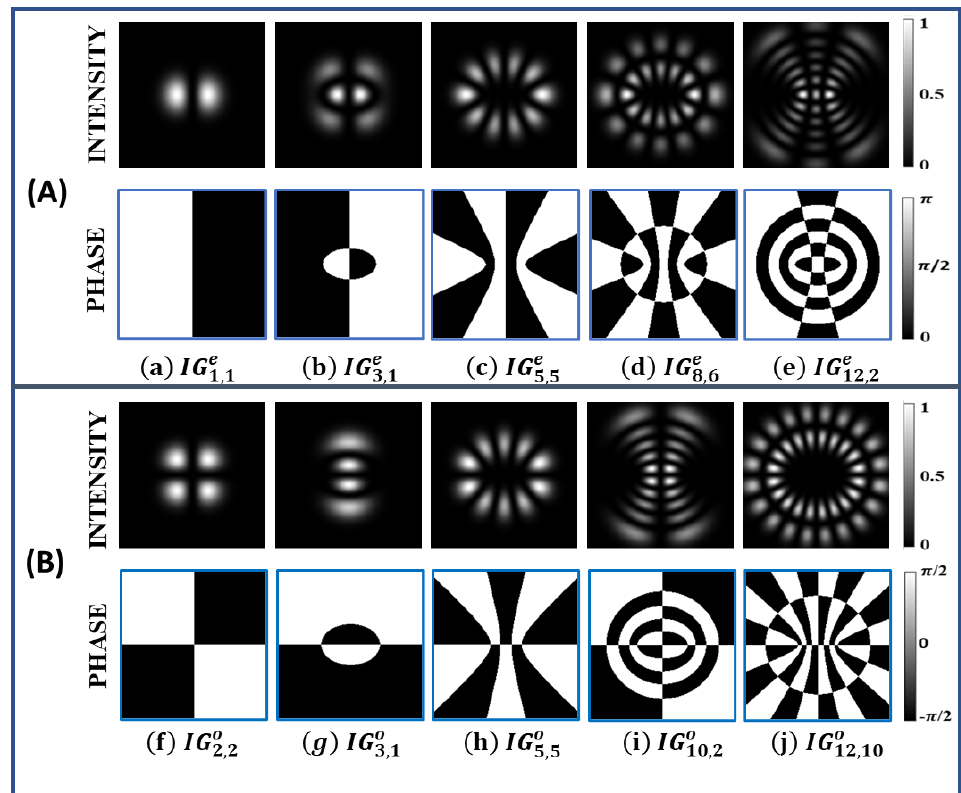
Figure 1. ( A ) Intensity (first row) and phase (second row) profile of even Ince − Gaussian beams ( a ) IG e , ( b ) IG e , ( c ) IG e , ( d ) IG e , ( e ) IG e for (cid:101) = 2. ( B ) Intensity (first row) and phase (second 5,5 8,6 1,1 3,1 12,2 row) profile of odd Ince − Gaussian beams ( f ) IG o , ( g ) IG o , ( h ) IG o , ( i ) IG o , ( j ) IG o for (cid:101) = 2,2 5,5 3,1 10,2 12,10